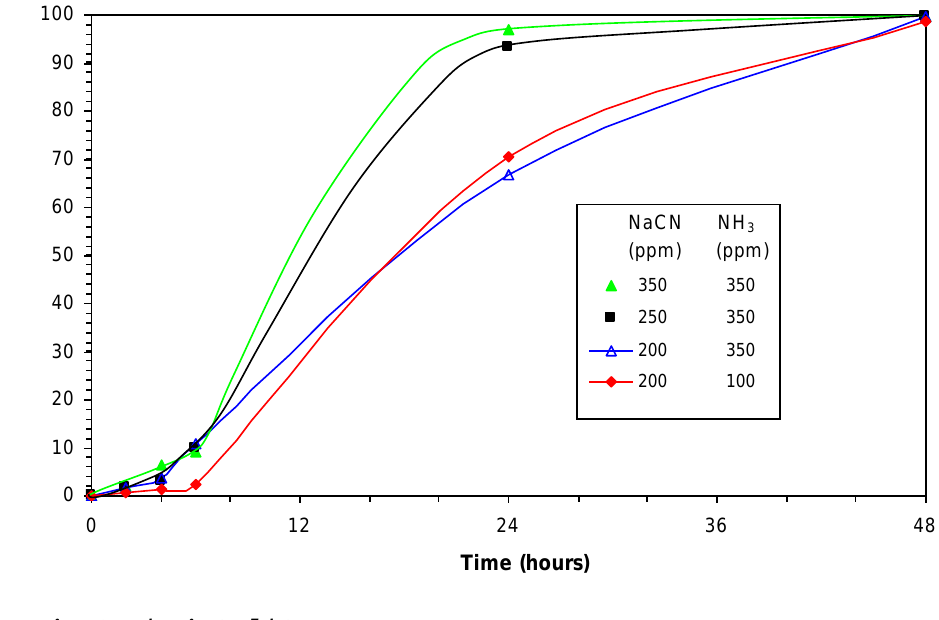
Figure 5. Effect of NaCN concentration on gold extraction in presence of djurleite; 0.3% Cu, 15 ppm DO, pH